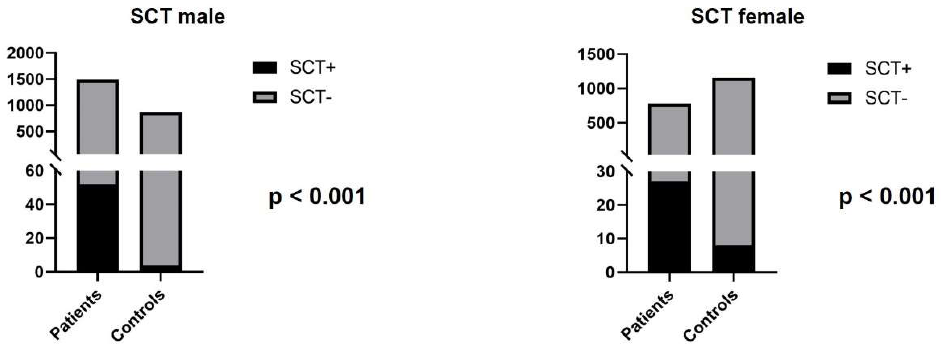
Figure 5. The number of SCTs in infertile patients and control individuals.